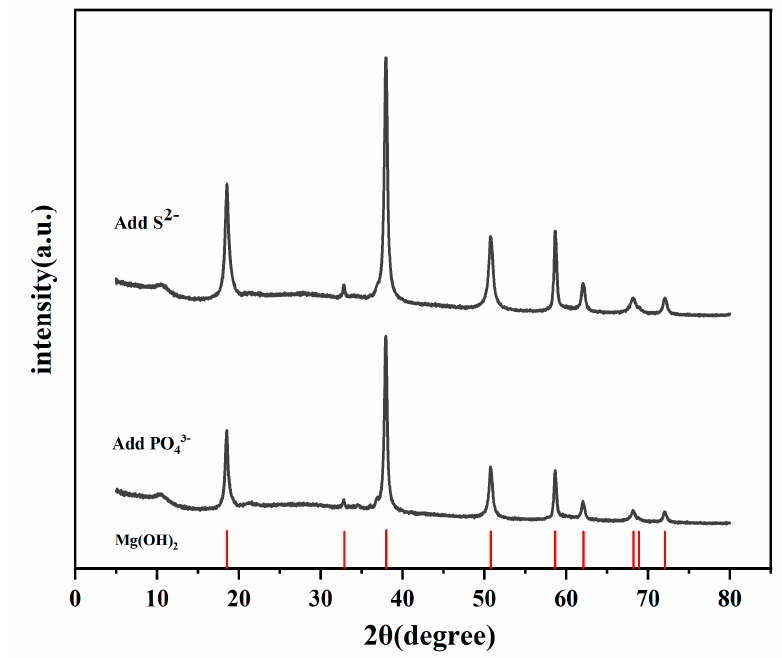
Figure 8. XRD patterns of the precipitates in 3.5%NaCl solution containing 0.4 mmol/L PO 43 − and 4 mmol/L S 2 − after 14 days and the corresponding standard peaks. Table 6. Potential polarisation curve parameters for magnesium alloy immersed in different solu- tions for 14 days.